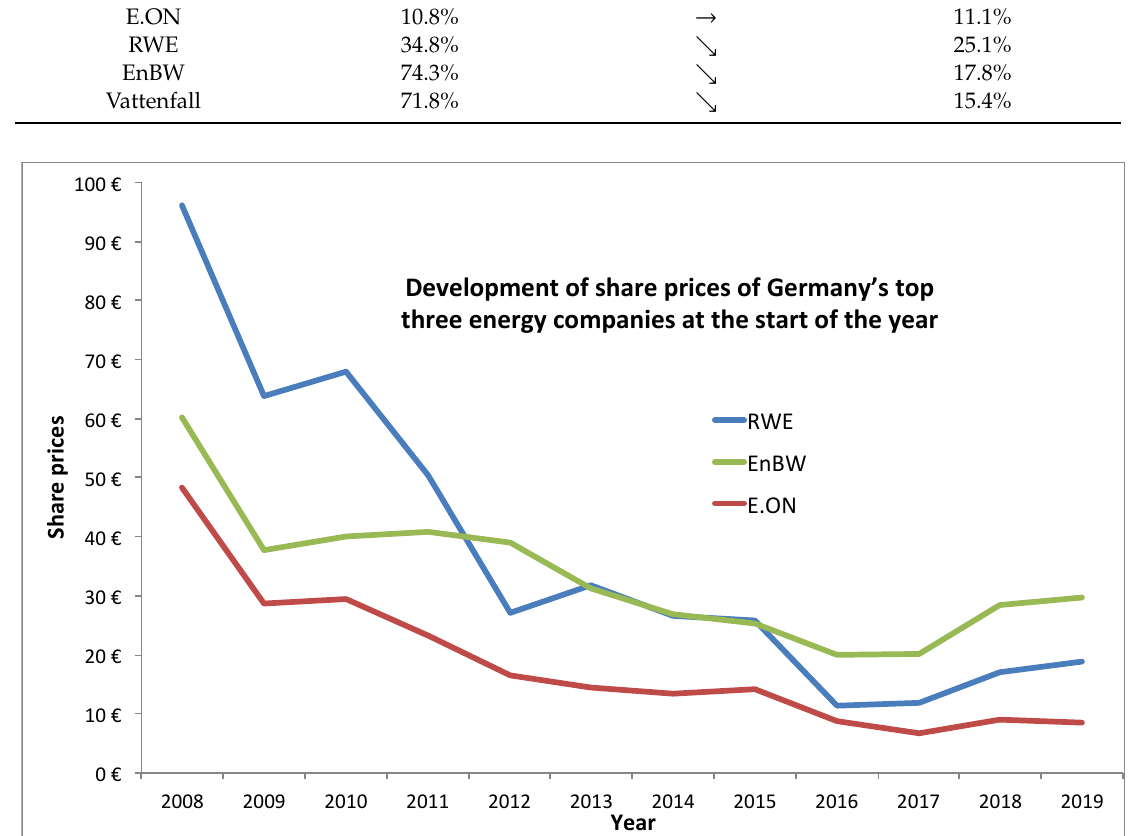
Figure 1. Development of the share price of Germany’s top three energy companies.